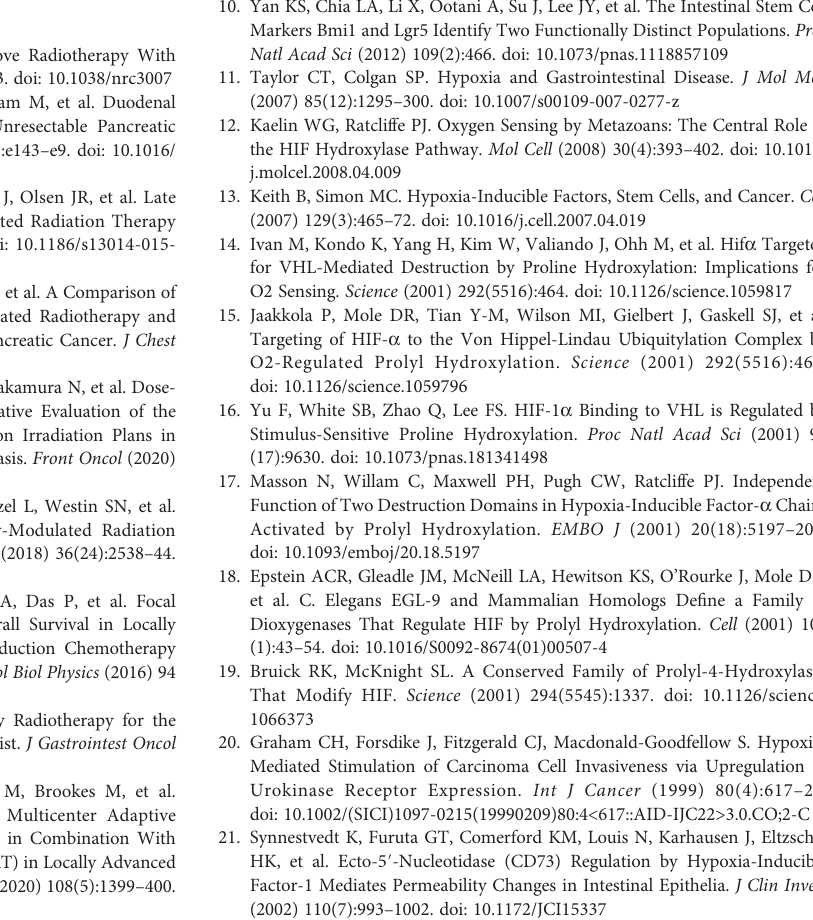
Supplementary Table 2 | Differentially Expressed Genes in HIF2-overexpessing duodenal organoids versus wild-type duodenal organoids. Supplementary Table 3 | Differentially Expressed Genes in HIF1-overexpessing duodenal organoids versus wild-type duodenal organoids. Supplemental Figure 1 | Differentially expressed gene pro fi le in HIF1- overexpressing duodenal organoids. (A) Heatmap shows all the differentially expressed genes in duodenal organoids infected with Adeno-hHIF1 or control